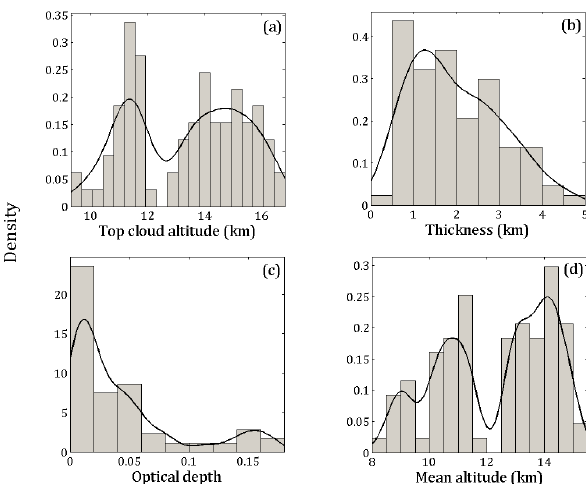
Figure 10. Probability Density Function (PDF) of the different characteristics of cirrus clouds 2 Fig. 10. Probability Density Function (PDF) of the different charac- teristics of cirrus clouds observed at Reunion Island over the period observed at Reunion Island over the period 2002-2005. The panels (a), (b), (c) and (d) 3 2002–2005. The panels (a) , (b) , (c) and (d) represent, respectively, represent respectively the top of cirrus clouds, geometrical thickness, the optical depth and the 4 the top of cirrus clouds, geometrical thickness, the optical depth and mean altitude. 5 the mean altitude.